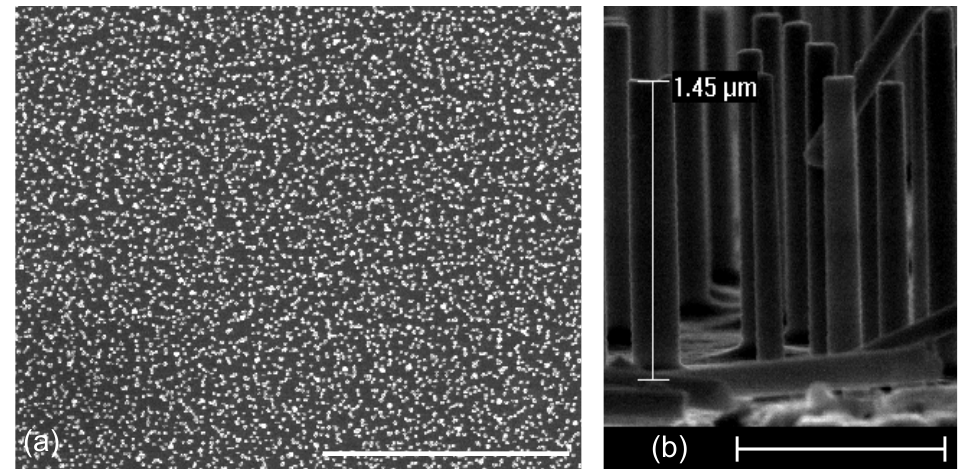
Figure 3. SEM images of Al/Si nanopillars obtained with our fabrication technique: ( a ) on a large zone (scale bar = 20 µ m); and ( b ) cross-section view of the nanopillars (scale bar = 1 µ